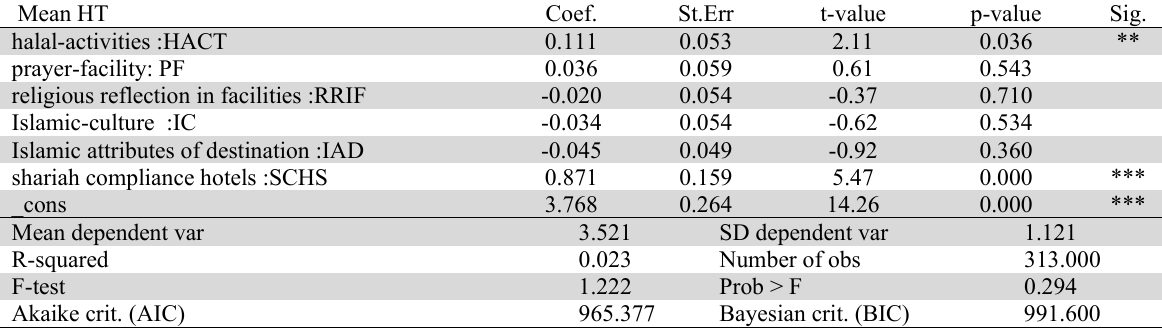
Muslim Friendly Holiday Packages and Halal Tourism